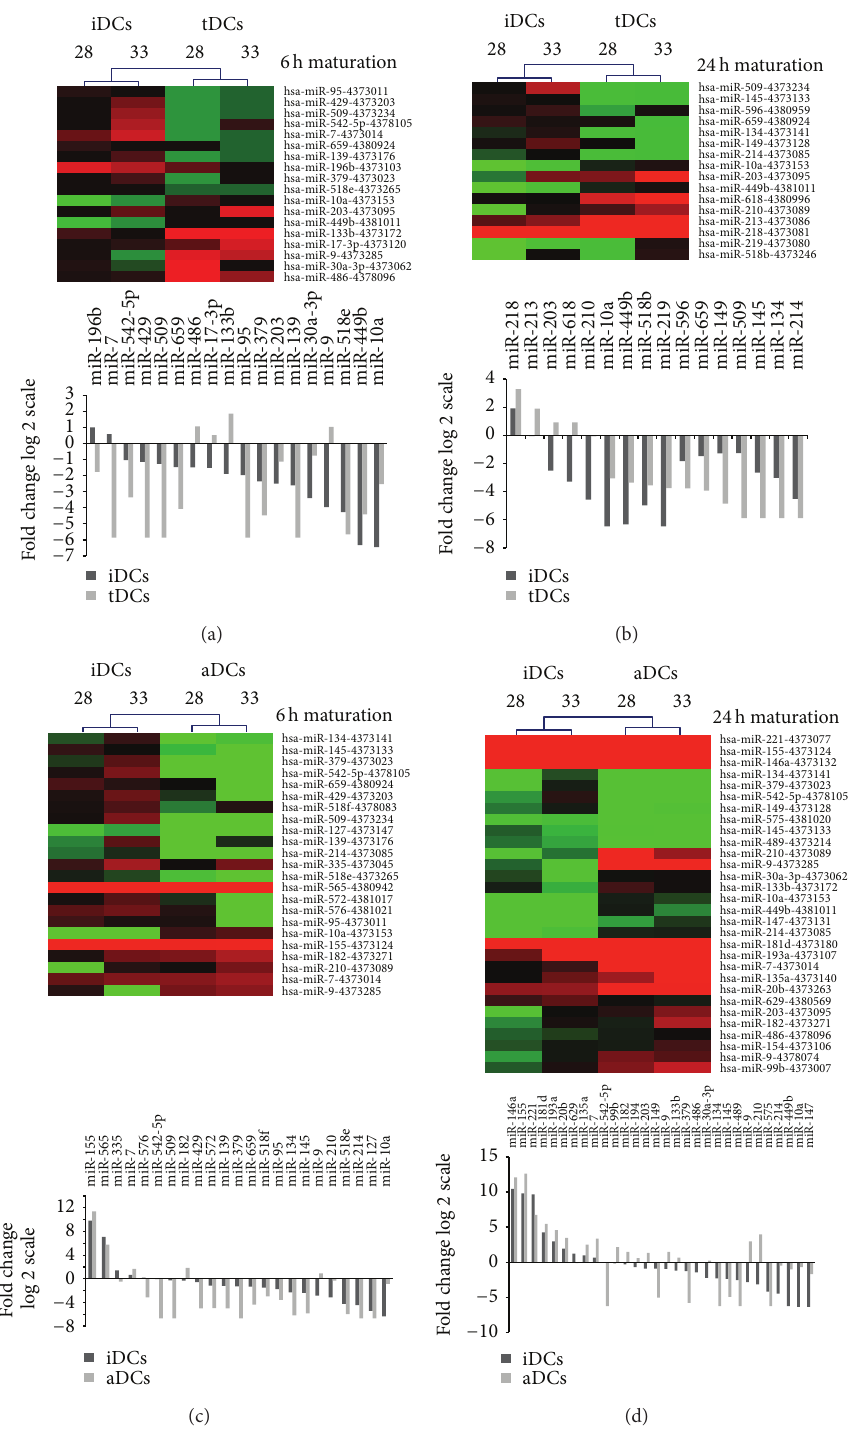
Figure 3: miRNAs profiles in activated and tolerogenic DCs in comparison to untreated DCs control. Immature iDCs were cultured with GM-CSF (800UI/mL) and IL-4 (500 UI/mL) for 6 days. On day 6, the media were replaced for iDCs containing LPS/IFN- 𝛾 (aDCs) or containing IL-10/TGF- 𝛽 (tDCs) for next 6h or 24h maturation. The q-PCR based TLDA miRNA expression analysis was provided in all DCs samples. The gene expression values for miRNAs were normalized using RNU6B as an endogenous control. The relative expression levels of target miRNAs were determined by the equation 2 −Δ Ct , in which Δ Ct were calculated as follows: Δ Ct = CtmiR-of-interest − Ct RNU6B. The observed changes in miRNA expression with fold change higher than twofold were analyzed. The results are visualized through heat maps and dendrograms. Green-red colour scale display in the heat maps increasing miRNA in measured samples. (a) miRNA expression in iDCs versus 6 h tDCs. (b) miRNA expression in iDCs versus 24 h tDCs. (c) miRNA expression in iDCs versus 6 h aDCs. (d) miRNA expression in iDCs versus 24 h